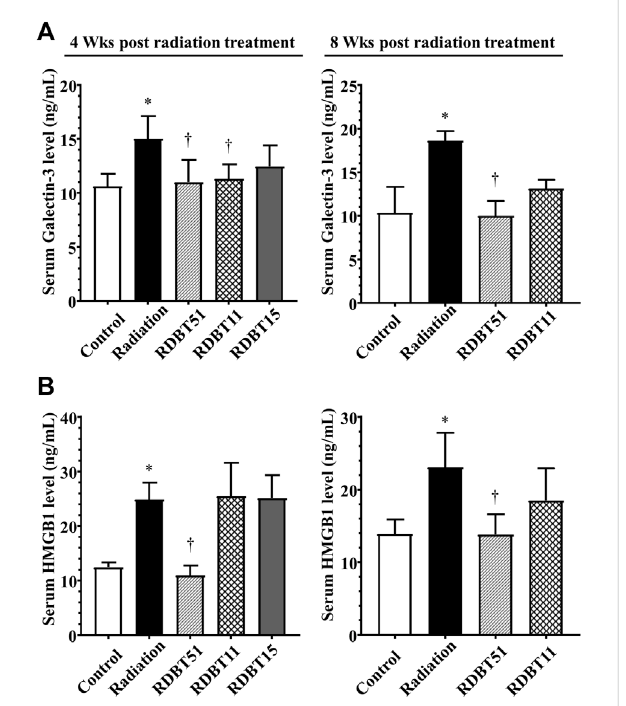
FIGURE 6 The DBT reduces the fi brosis-related biomarkers in the serum of mice at 4 and 8 weeks after radiation. (A) Galectin-3; (B) HMGB1. * p < 0.05 versus Control; † p < 0.05 versus Radiation. DBT, Dang Gui Bu Xue Tang; HMGB1, high mobility group box 1; RAM, Radix Astragali membranaceus ; RAS, Radix Angelicae sinensis ; RDBT51, Radiation with DBT (RAM: RAS = 5:1); RDBT11, Radiation with DBT (RAM: RAS = 1:1); RDBT15, Radiation with DBT (RAM: RAS = 1:5).